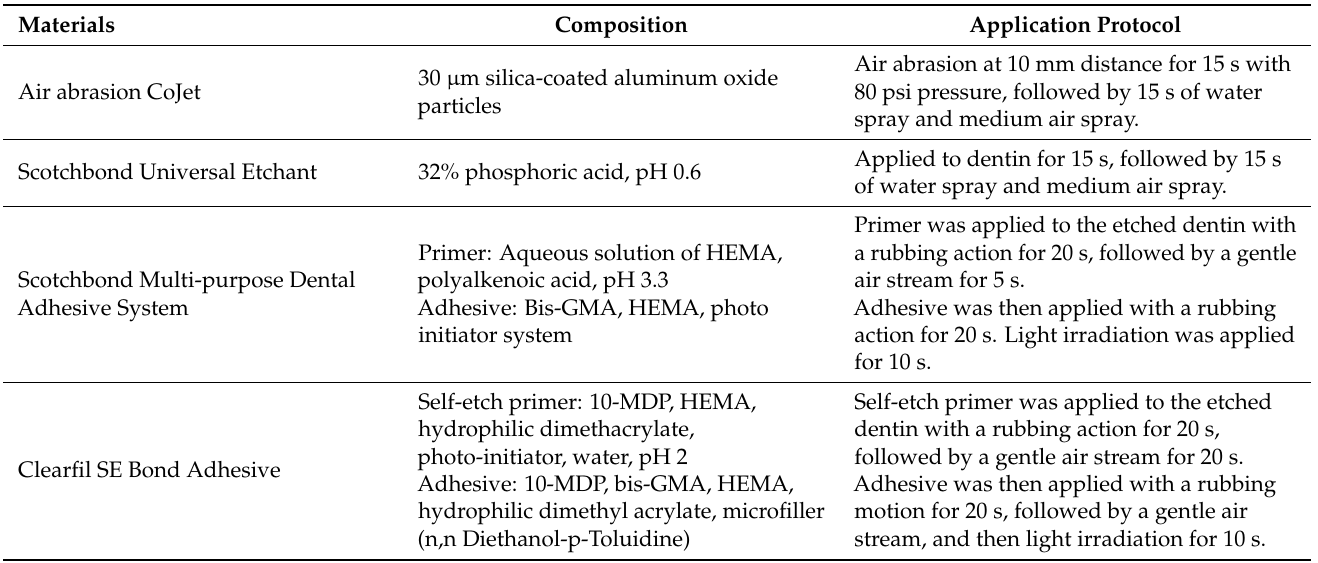
Table 1. The application protocol and composition of the adhesives and air abrasion system.